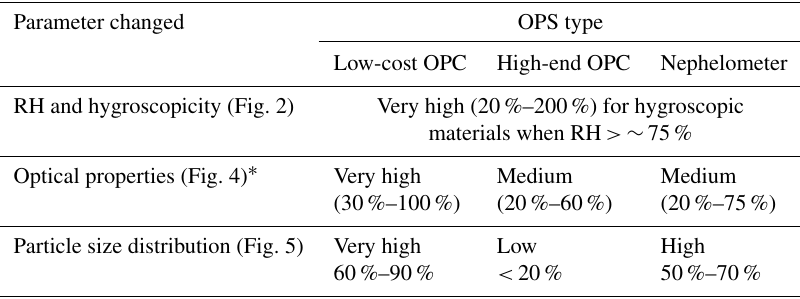
Table 3. Effects of changing environmental and/or aerosol parameters on the relative error in measured mass loading by different OPS types. Parameter